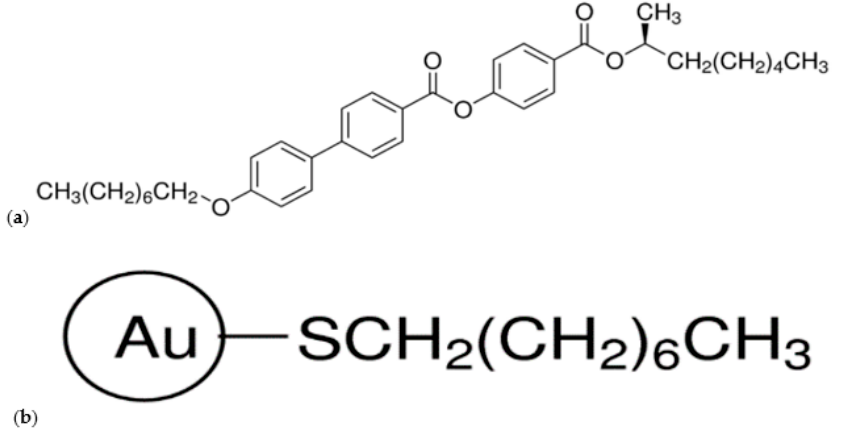
Figure 15. Chemical structure of liquid crystal (S)-MHPOBC ( a ) and the 1-octanethiol functionalized gold nanoparticle ( b ).